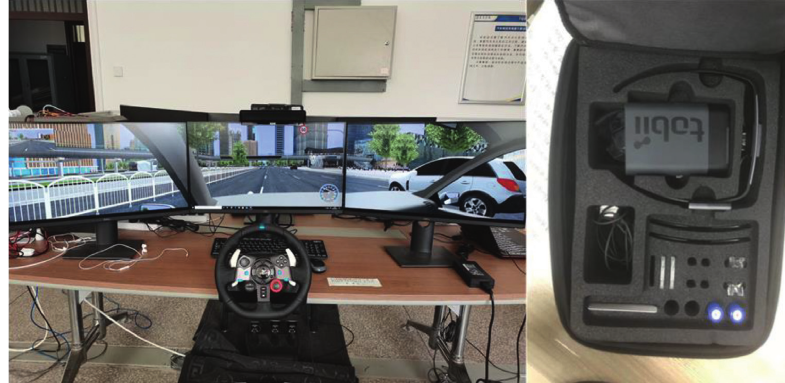
Figure 2: Driving simulator and eye tracker.